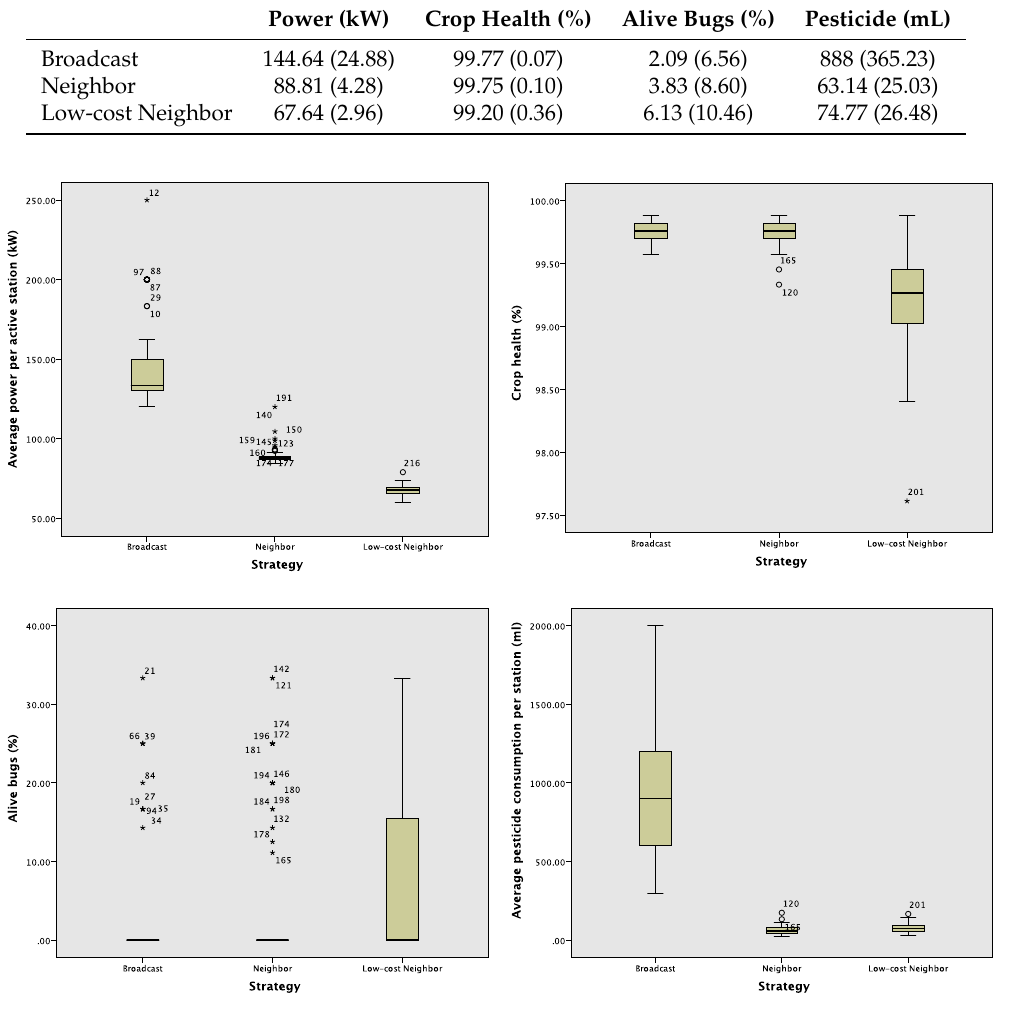
Figure 5. Boxplots for comparing the three communication protocol